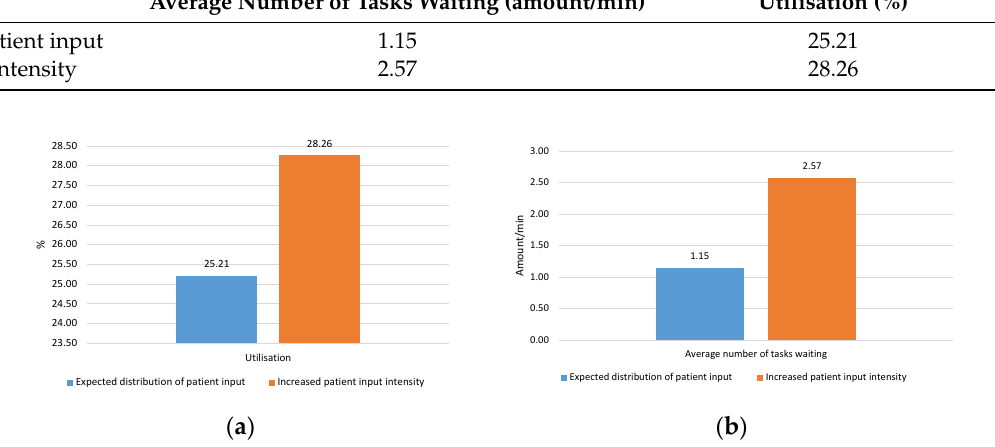
Figure 15. Graphical representation of simulation experiment results for the combined use of surface and spatial disinfection AGV: ( a ) utilisation; ( b ) average number of waiting tasks.